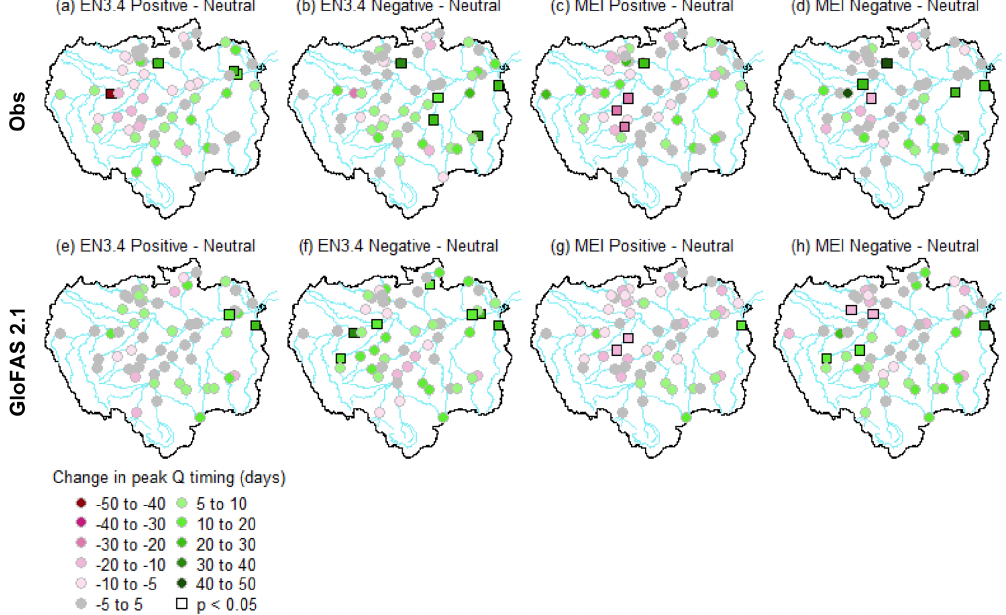
Figure 5. Average change in the timing of observed and simulated annual peak river flows between different phases of the EN3.4 and MEI indices. (a, c, e, g) Positive with respect to neutral years. (b, d, f, h) Negative with respect to neutral years. Panels (a–d) represent changes for observations and panels (e–h) show changes for GloFAS 2.1 streamflow reanalysis data. Pink (green) points represent where flood peaks occur earlier (later) compared to neutral conditions. Significant results at the 95% confidence level are denoted using a square (i.e. p < 0 .